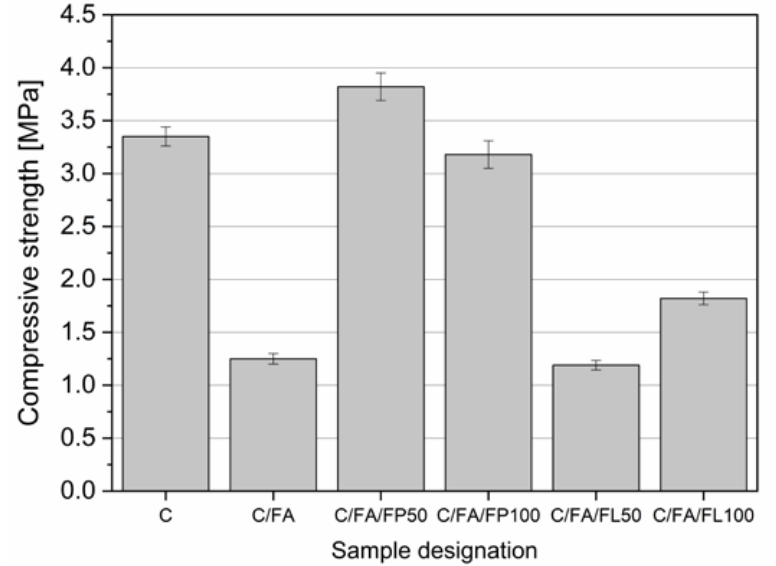
Figure 3. Compressive strength of foamed concrete mixes at 28 days.